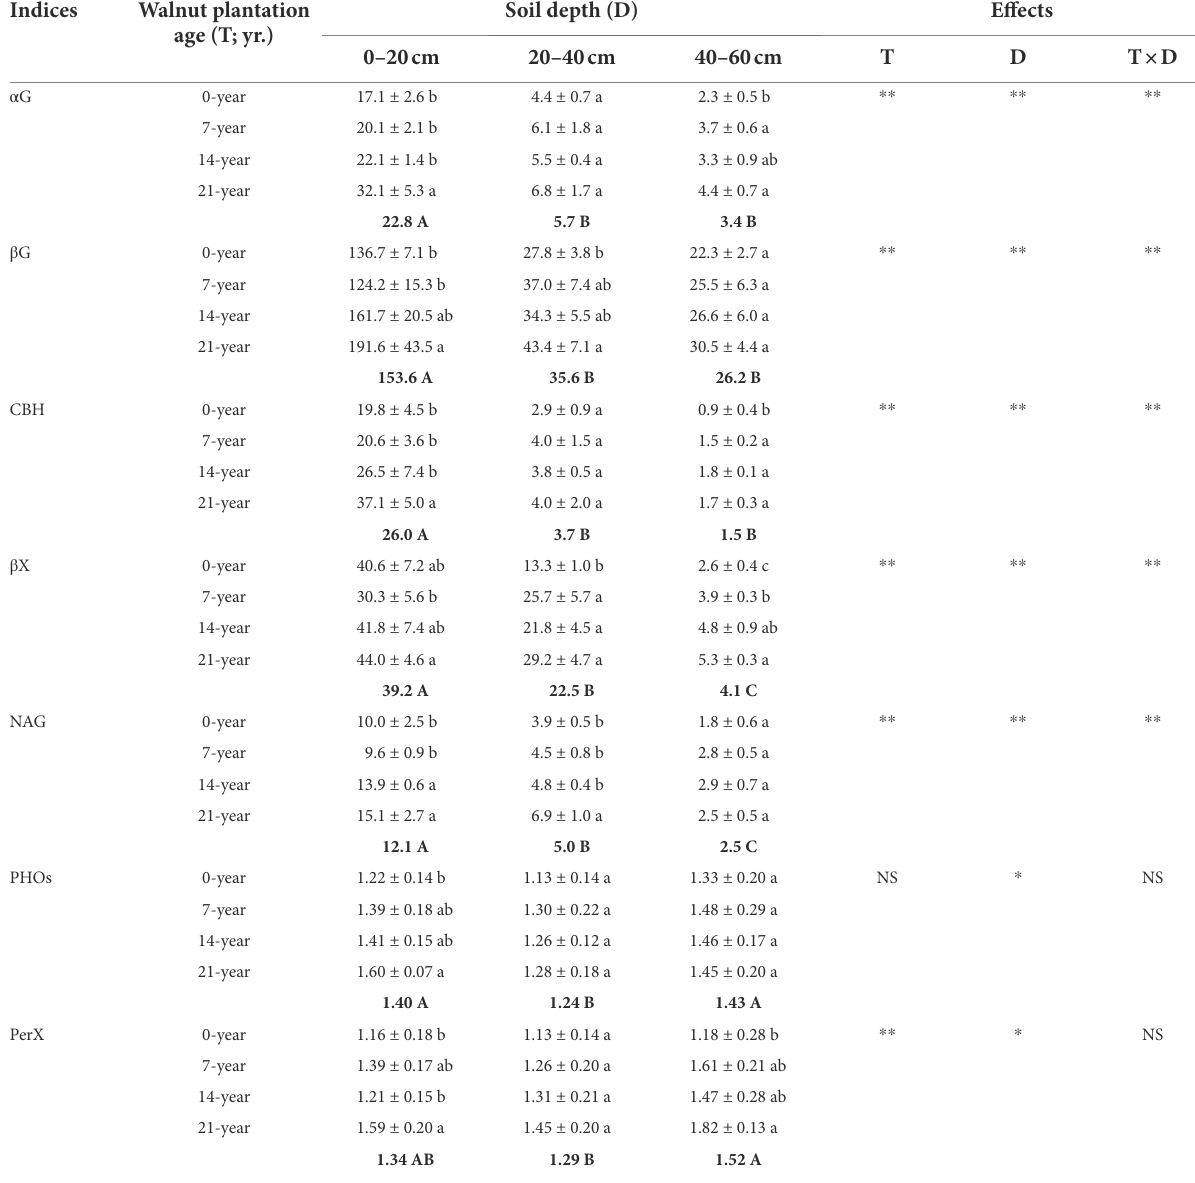
TABLE 3 The extracellular enzyme activities (g − 1 soil h − 1 ) at three soil depths (0–20, 20–40, and 40–60 cm) under different ages of walnut plantations. Indices Walnut plantation age (T;